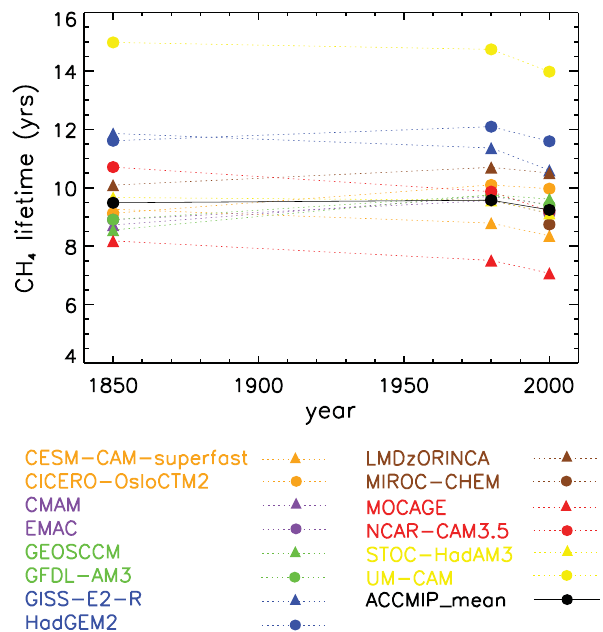
Fig. 1. Evolution of global tropospheric chemical methane lifetime in the ACCMIP models, for the historical period. Multi-model mean values (black dots connected with solid line) were only plotted for timeslices with data from at least 7 models, after removing results from HadGEM2 and